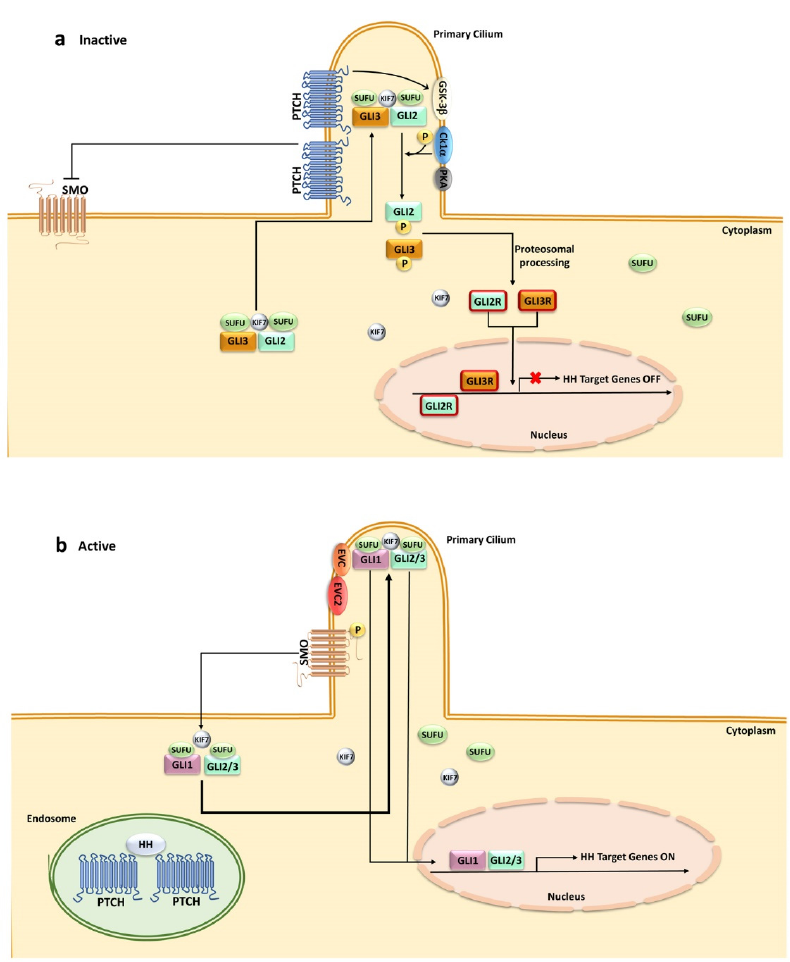
Figure 1. HH signaling in mammals. A simplified cartoon illustrating activation of HH pathway in mammalian cells: ( a ) in the absence of HH ligands, PTCH is localized at the primary cilium while SMO remains distant from the cilium. PTCH inhibits SMO by preventing its cilial entry. Several kinases (GSK-3 β , CK1- α , PKA) are recruited by the GLI/SUFU/KIF7 complexes and activated by PTCH. GLI transcription factors are phosphorylated by these kinases, which promote their pro- cessing into the repressor forms, translocating to the nucleus, and thereby blocking HH target gene transcription; ( b ) HH ligand binding to PTCH relieves SMO inhibition. PTCH is endocytosed and displaced from the cilium, whereas SMO accumulates in the cilium in an active state. The GLI/SUFU/KIF7 complexes are recruited by SMO. SMO activation results in the detachment of GLI transcription factors from SUFU and KIF7 with the aid of EvC and EvC2. GLI transcription factors migrate to the nucleus, activating gene transcription. CK1- α , casein kinase 1- α ; EvC, Ellis–Van Creveld Syndrome; GLI-R, GLI repressor; GSK-3 β , glycogen synthase kinase 3 β ; KIF7, kinesin fam- ily protein 7; PKA, protein kinase A; PTCH, Patched; SMO, Smoothened; SUFU, suppressor of fused. In addition to the canonical pathway of activation, GLI transcription factors could be activated via noncanonical mechanisms (which bypass the HH ligand–PTCH/SMO axis), mostly in cancer cells [45], as we shall discuss in Section 3.2.